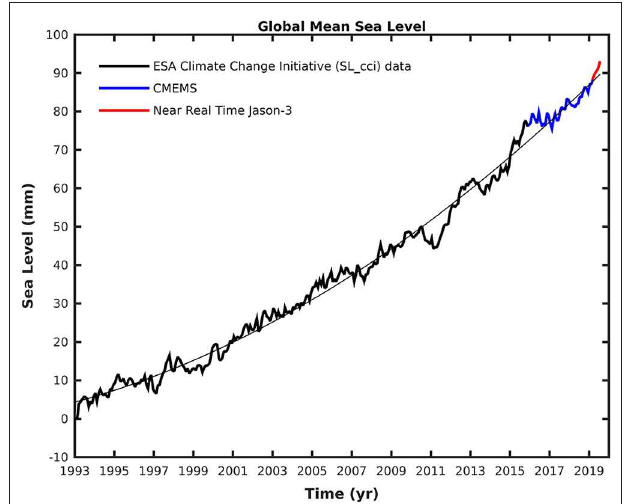
FIGURE 4 | Altimetry-based global mean sea level from January 1993 to February 2019. The black thin solid line is a quadratic function fitted to the